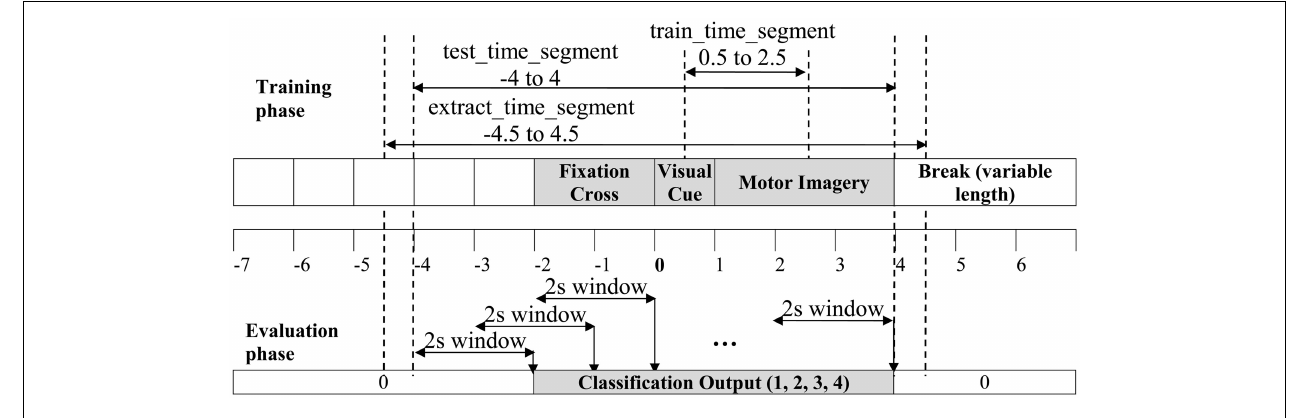
classification outputs using the multi-class extension to FBCSP on the entire time segment of a single-trial for the evaluation phase.